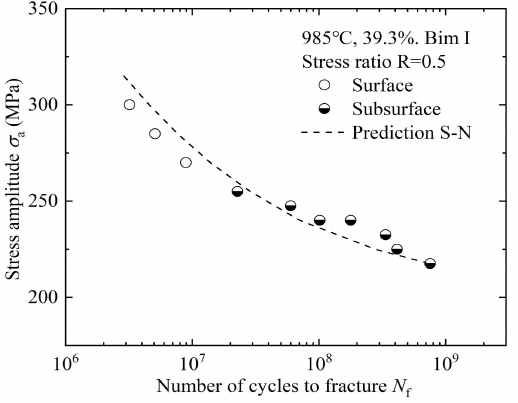
Figure 13. Results of the fatigue crack life